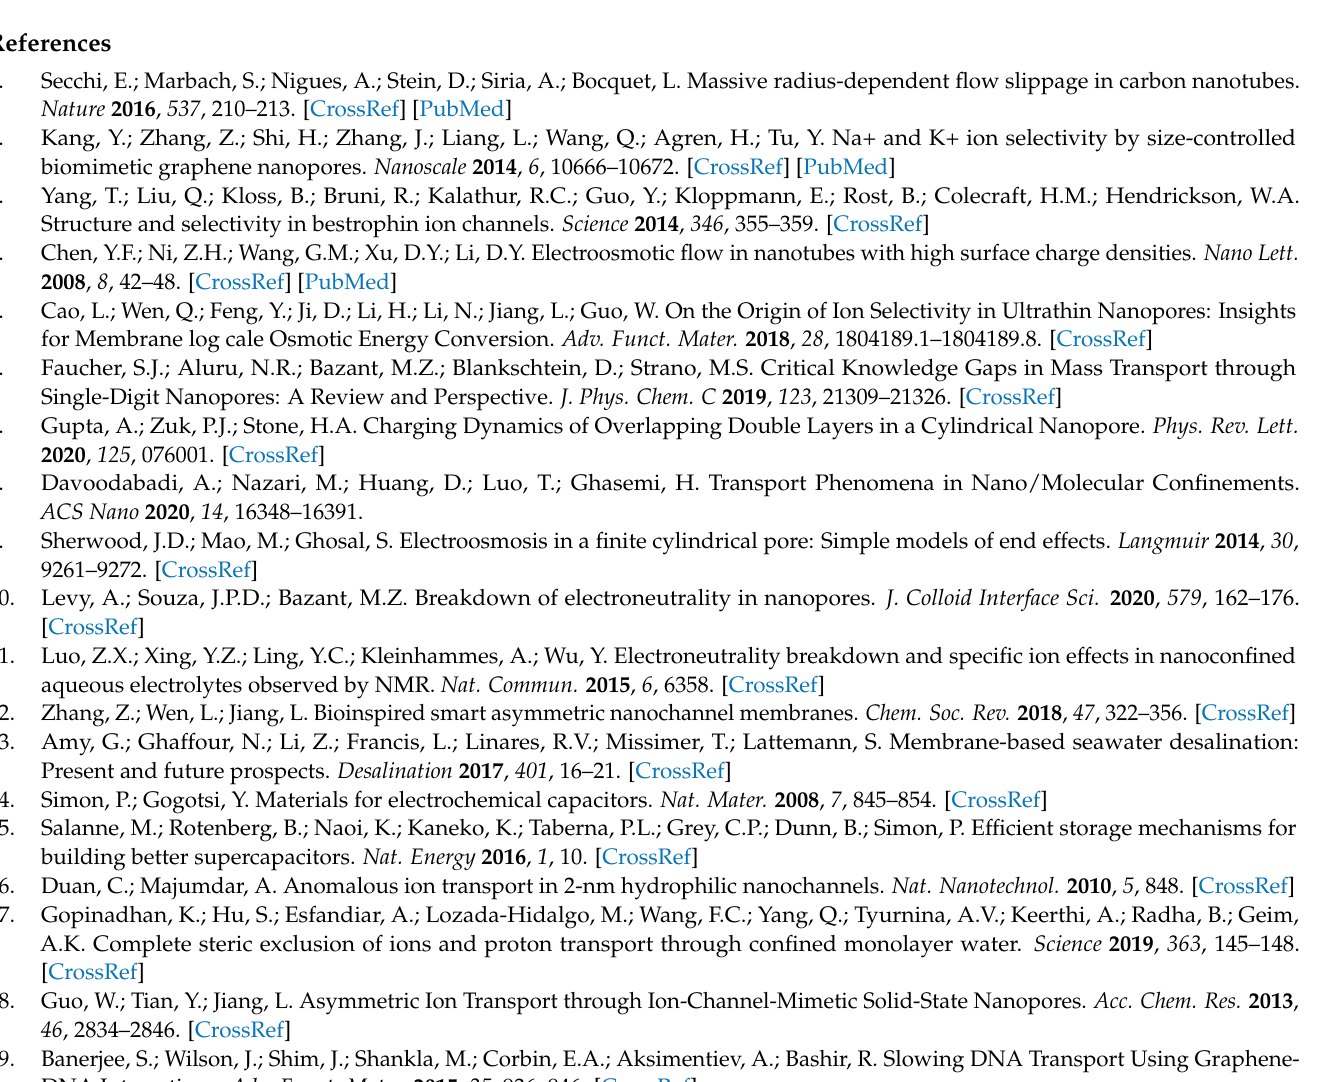
Figure S1: Water and ions passing through graphene nanopore. Figure S2: Ionic concentration inside the 2-nm